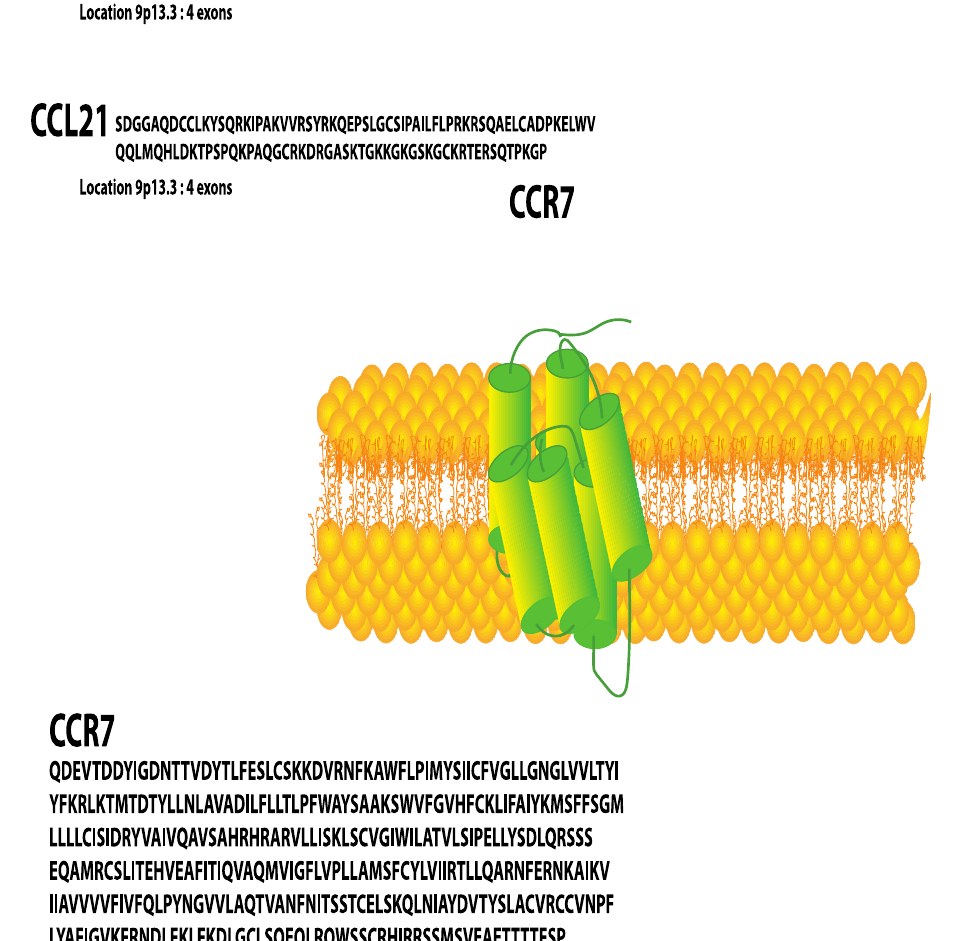
2022) [amino acids 24–134]).